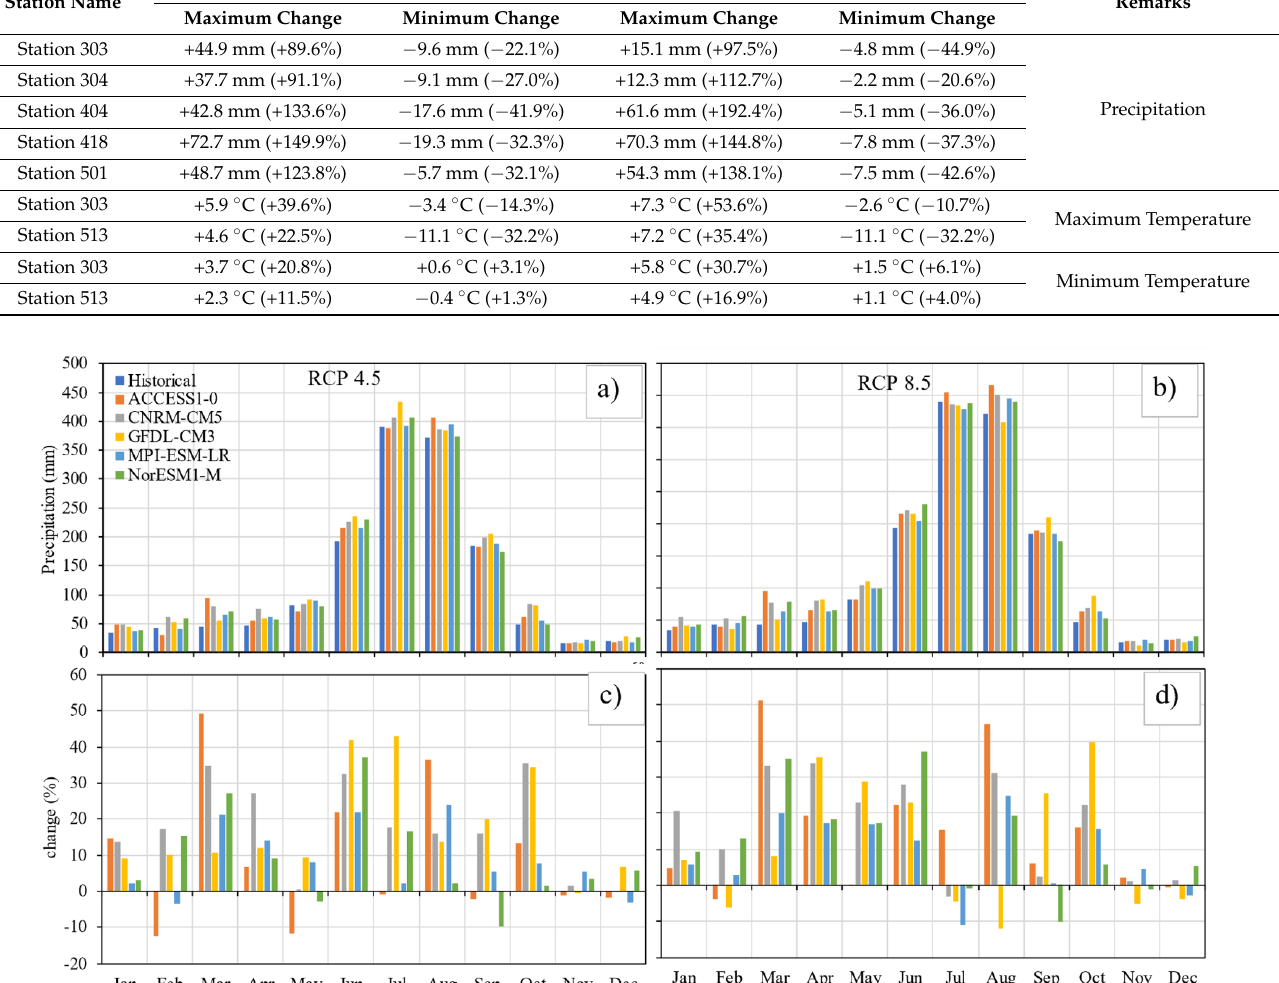
The drier months (October to February) showed the overestimation in maximum temper- ature projection, and the wetter months (March to September) showed the underestima- tion in the maximum temperature projection, which implies that summer temperature is projected to reduce, and the winter temperature is projected to increase in the future. The monthly projection in average minimum temperature showed an overestimated temper- ature projection when using all the climate models (Figure 4c,d). The change in projected average maximum temperature varied from −6.9 °C (NorESM1-M) to +4.9 °C (MPI-ESM-